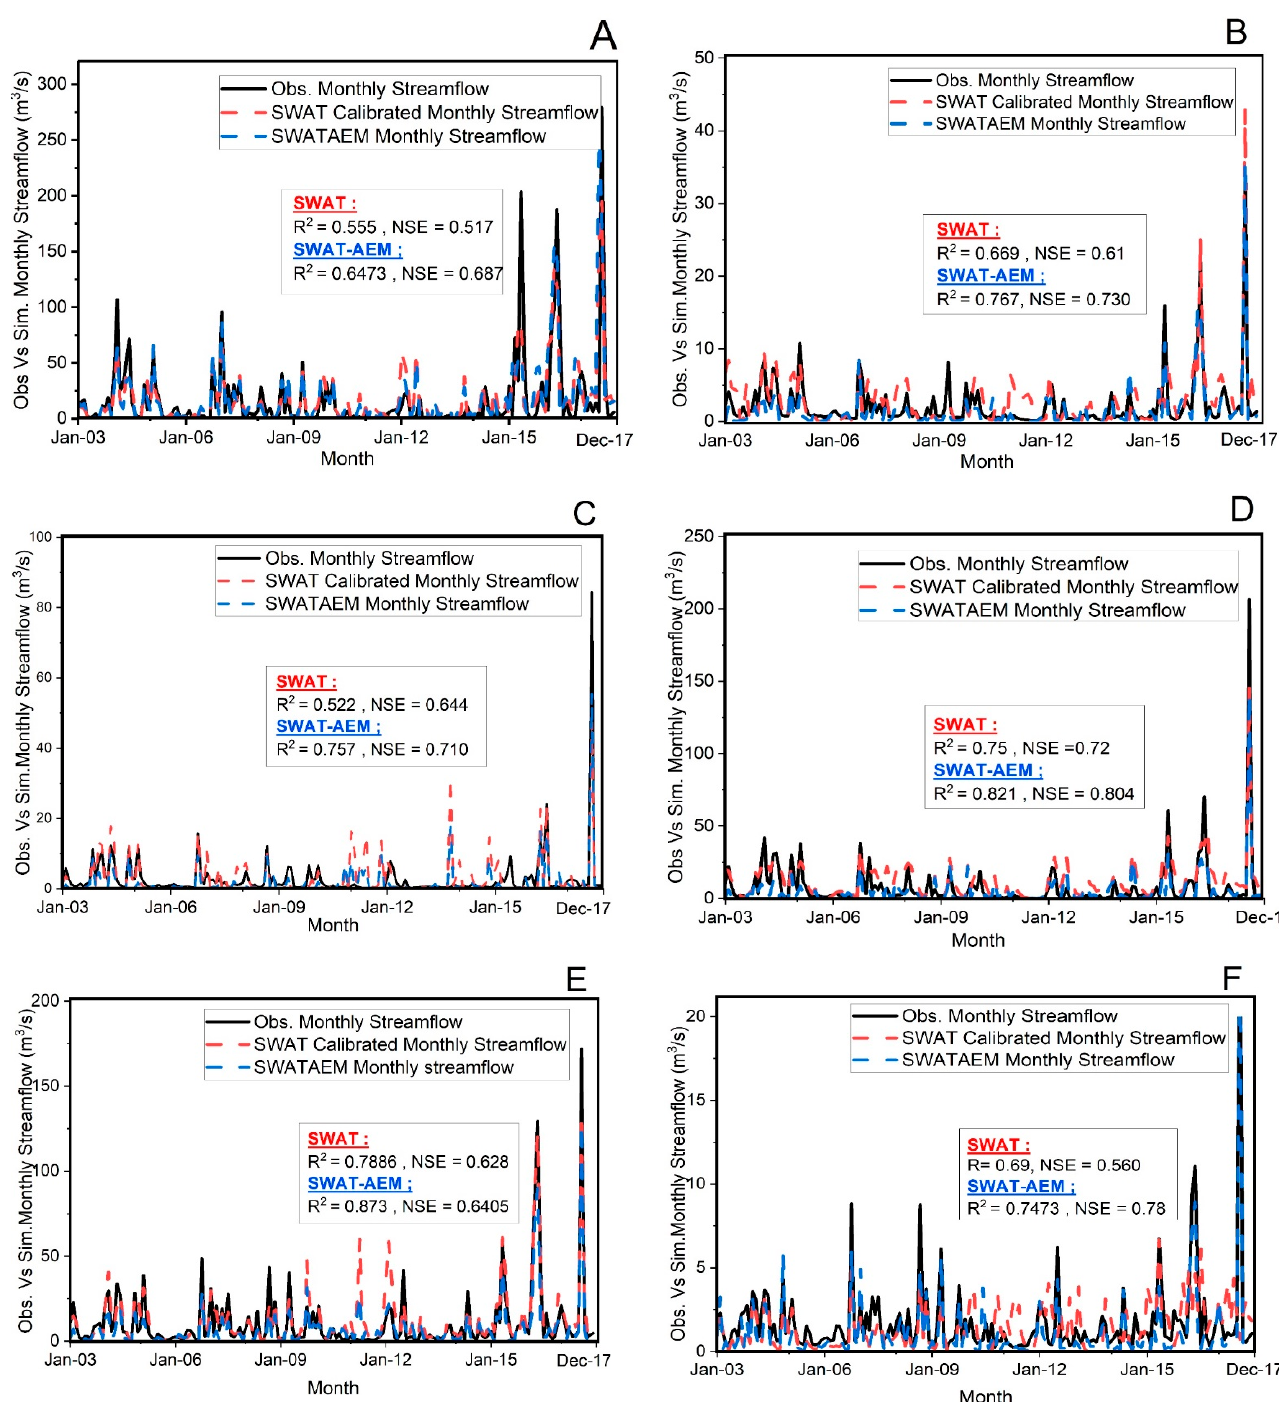
Figure 7. Flow Hydrograph for Observed and Simulated SWAT/SWATAEM stream flow (m 3 /s) for Seven gauge locations ( A ). USGS 08068090; ( B ). USGS 08070500; ( C ). USGS 08071000; ( D ). USGS 08070200; ( E ). USGS 08068500; ( F ). USGS 08068450 and ( G ). USGS 08069000.